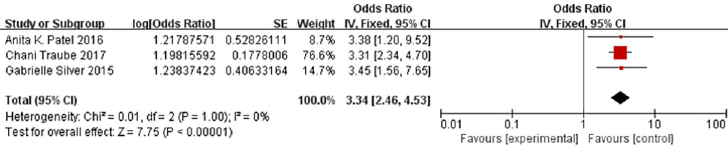
Fig 2. Forest plot for developmental delay analysis. We conducted meta-analysis for 3 studies using a random effect model. We used ORs and 95% CIs to represent the results.